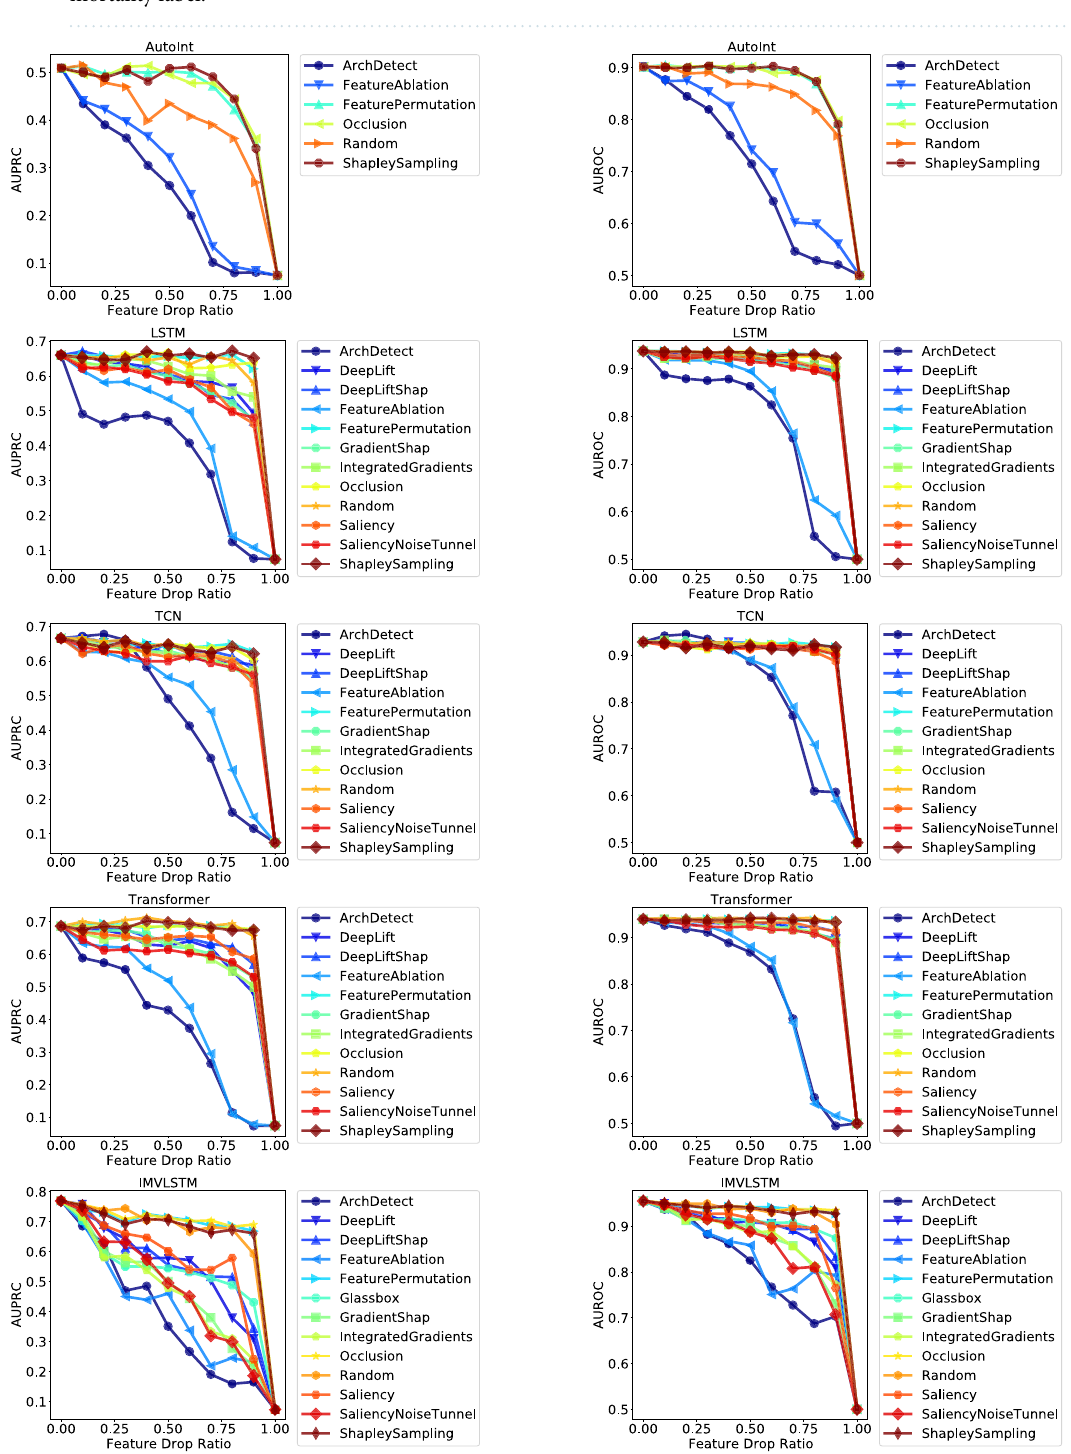
Figure 8. Curves of performance metric w.r.t feature drop